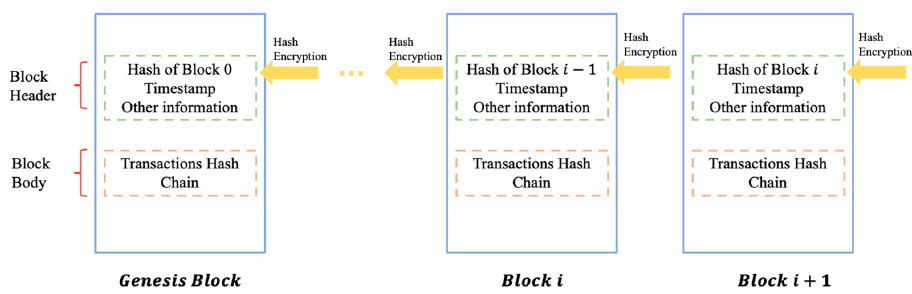
Figure 1. An example of blockchain which consists of a continuous sequence of blocks.